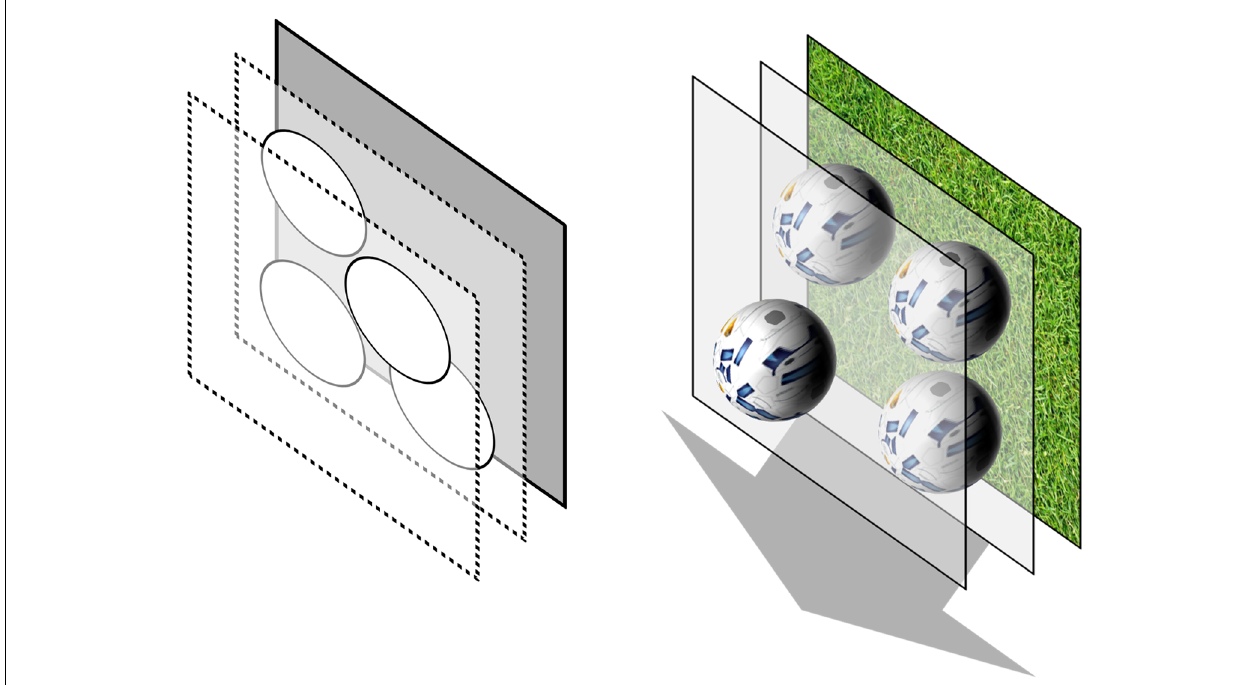
FIGURE 1 | Illustration in 3D of the static stereoscopic stimulus (left) and the dynamic stereoscopic stimulus (right). The target objects of the static test are stationary while the target objects of the dynamic test are constantly moving towards the observer.